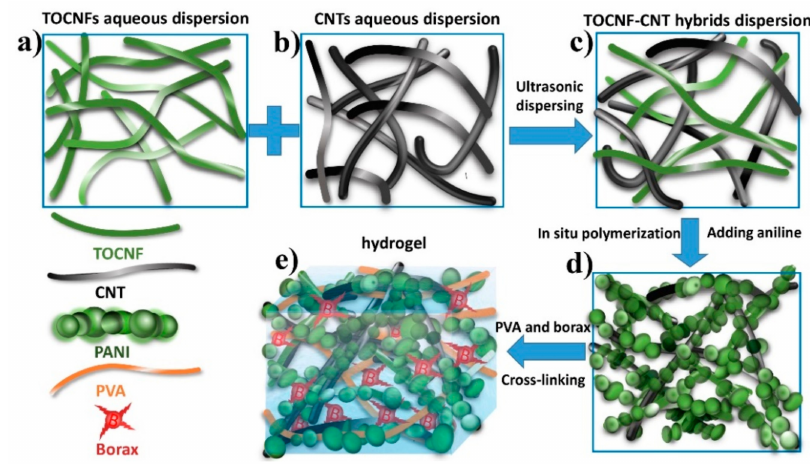
Figure 1. Schematic of the fabrication process of TOCNF-CNT@PANI / PVA composite hydrogel. ( a ) TOCNFs aqueous dispersion, ( b ) CNTs aqueous dispersion, ( c ) TOCNF-CNT nanohybrids aqueous dispersion, ( d ) TOCNF-CNT@PANI nanohybrids aqueous dispersion, ( e ) TOCNF-CNT@PANI / PVA composite hydrogel.